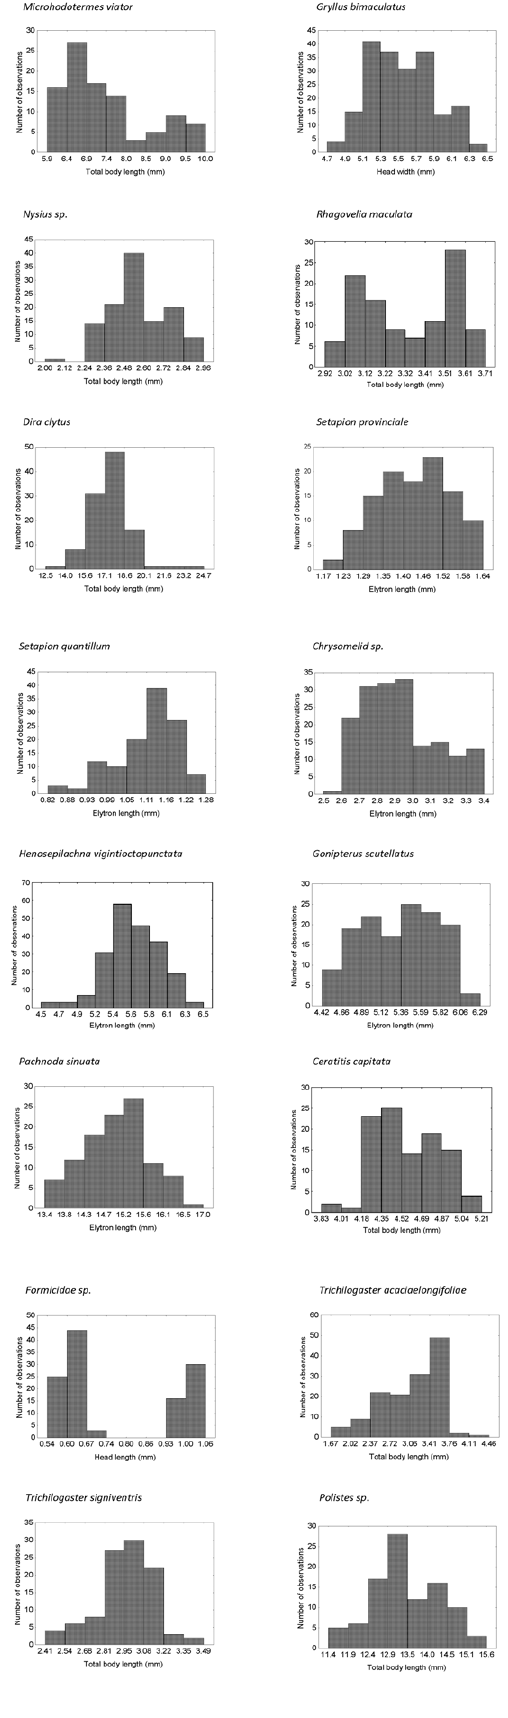
Figure 2. Body length frequency distributions of the 16 species sampled for this study. The length measurements were for different